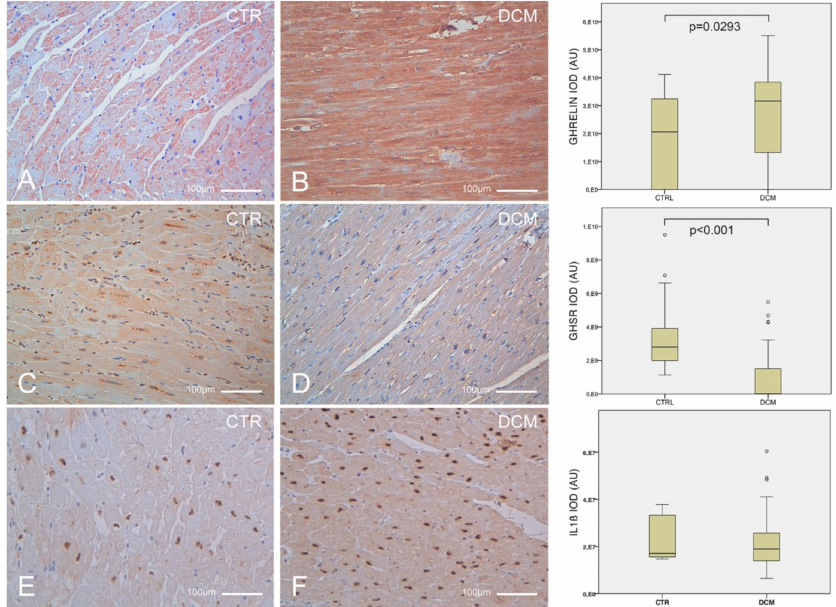
Figure 1. Quantitative assessment of ghrelin, leptin and of their receptors in human cardiac biopsies. Identification by immunohistochemistry staining (brown) of ghrelin prepropeptide ( A , B ) growth hormone secretagogue-receptor ( C , D ), and interleukin-1 β ( E , F ) expression in tissue biopsies of control hearts ( A , C , E ) and hearts explanted from patients a ff ected by dilated cardiomyopathy ( B , D , F ). Scale bars = 100 µ m. Boxplots summarize the results of the quantitative assessment of each staining, evaluated as integrated optical density